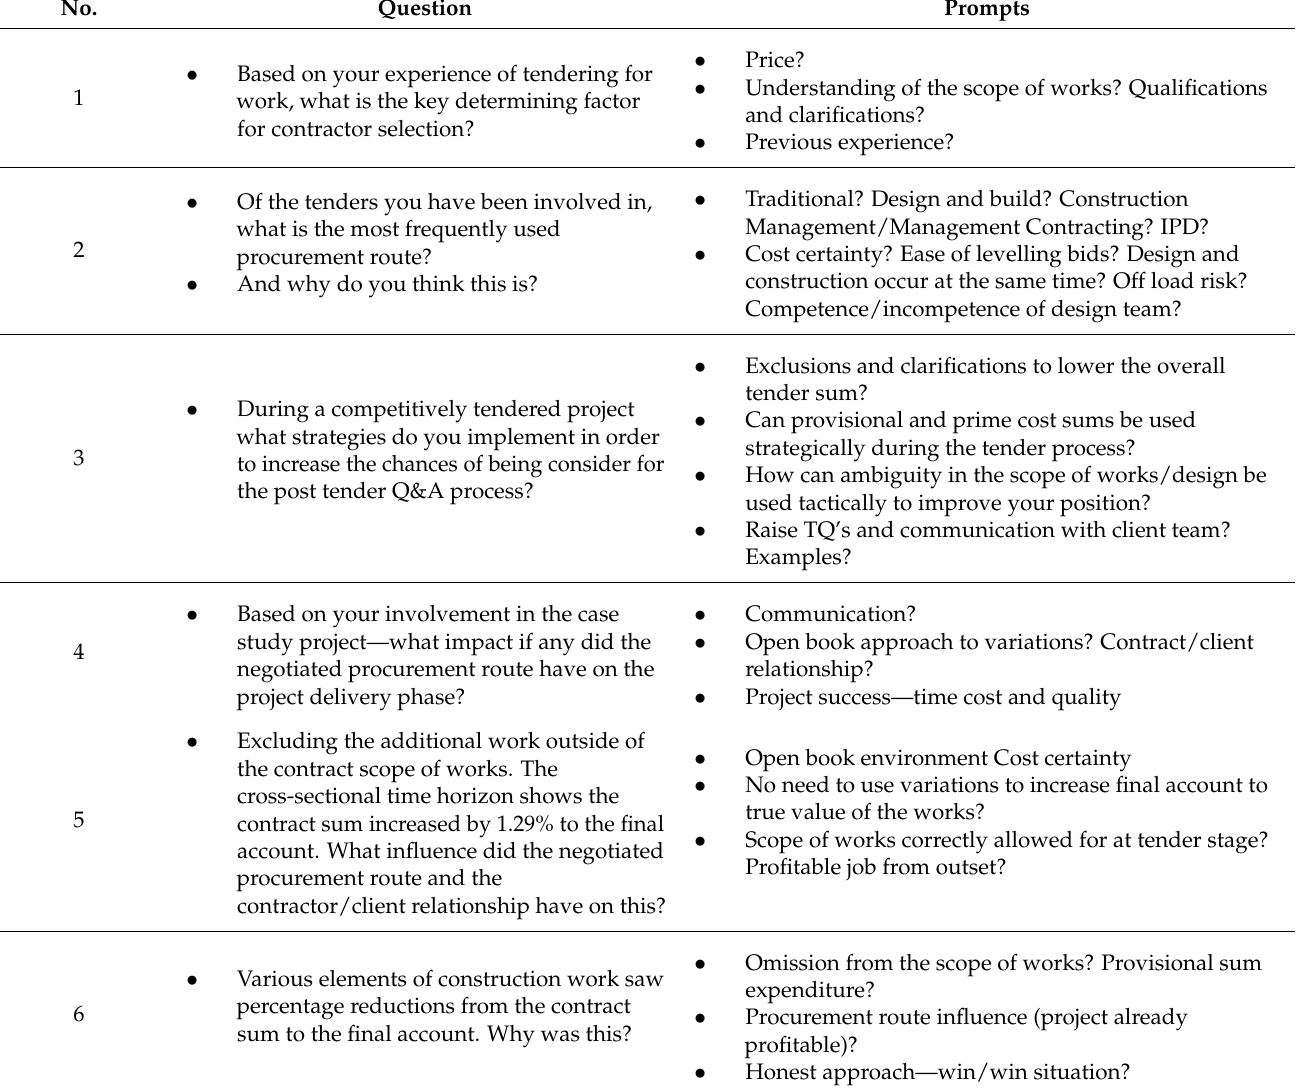
Table 9. Focus group